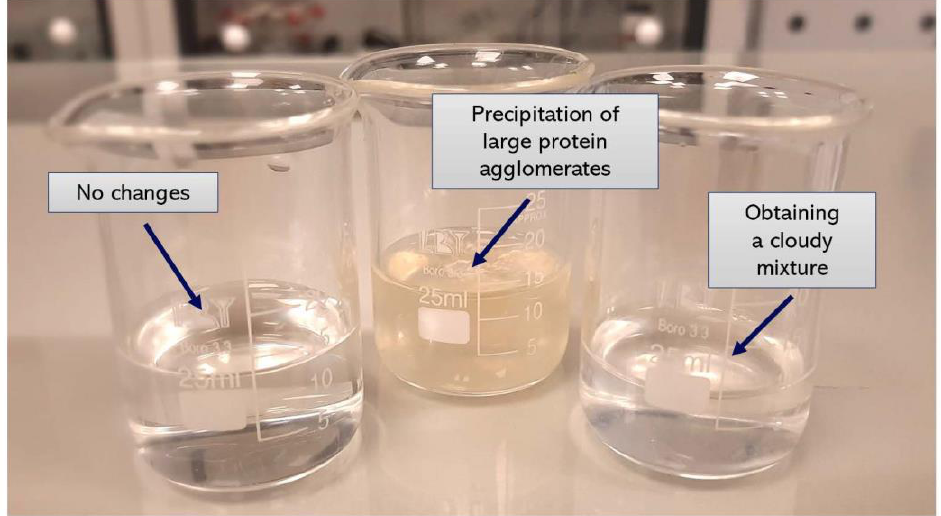
Figure 5. Examples of the compositions prepared.